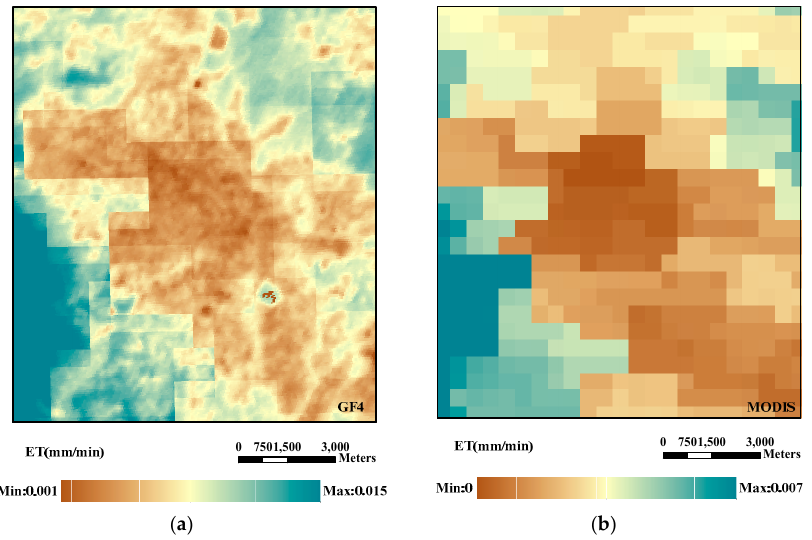
Figure 2. ET of GF-4 at 11:36( a ) and ET of MODIS at 11:35 ( b ) in area CB.